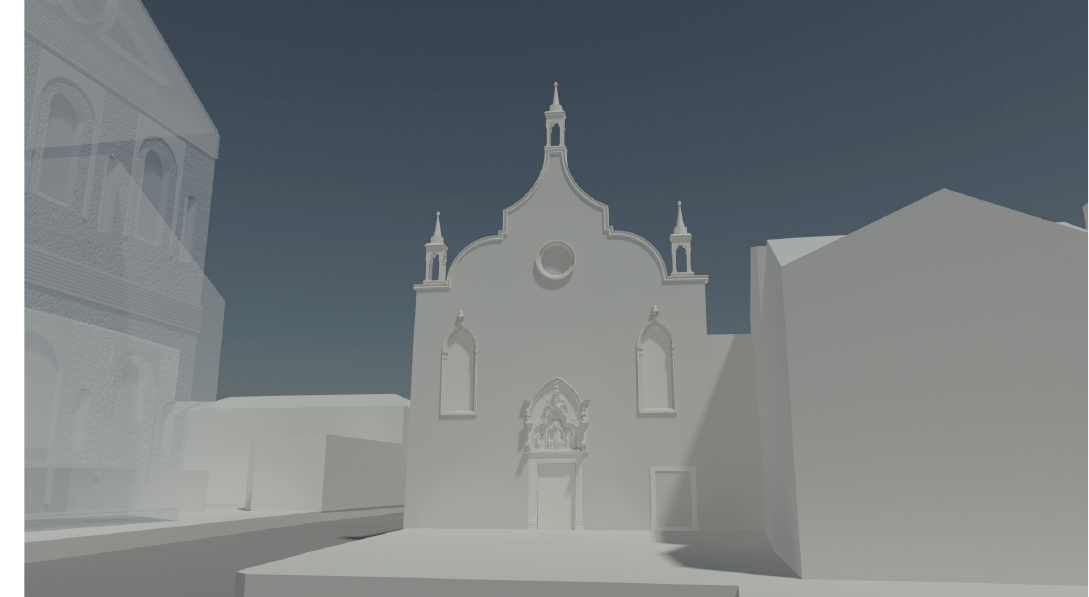
Figure 9: the reconstruction of the original façade dated XIV